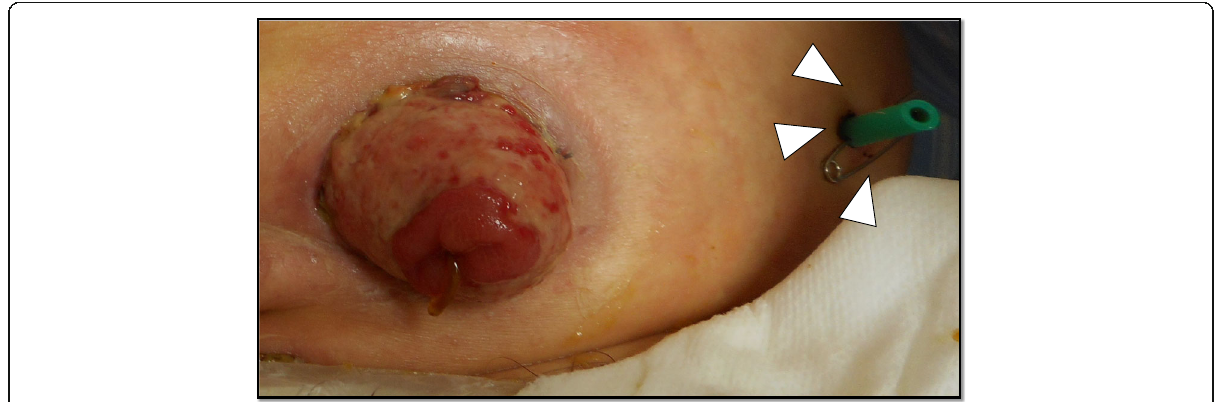
Fig. 3 We immediately performed the drainage of the abscess from the left lower quadrant abdominal wall laterally near the colostomy and indwelled an 18-Fr silicon drain tube for 8 days